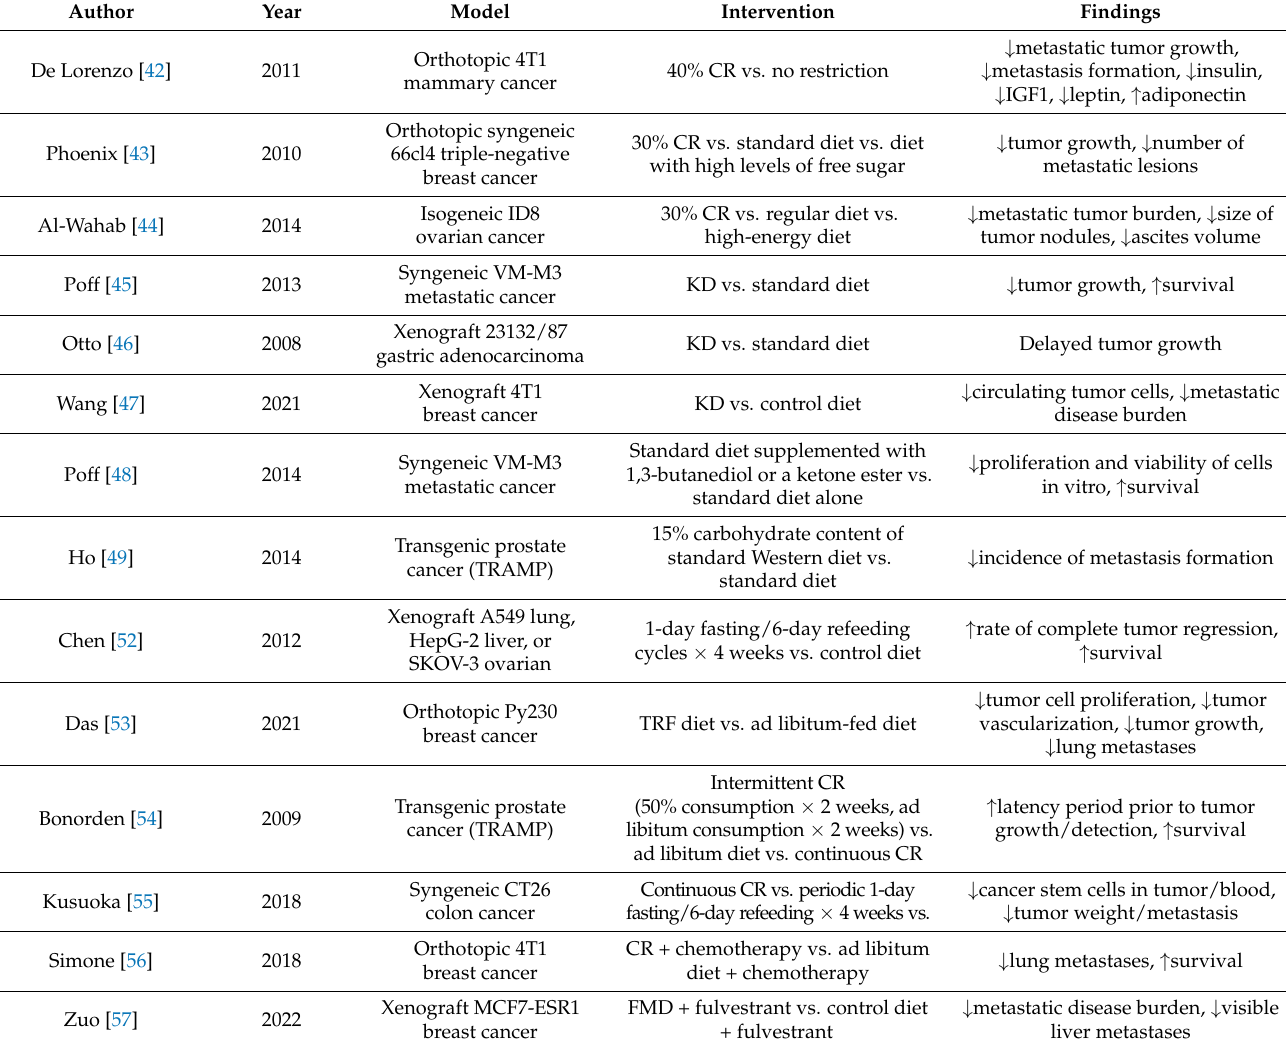
Table 1. Summary of preclinical studies testing insulin-lowering dietary strategies in models of metastatic